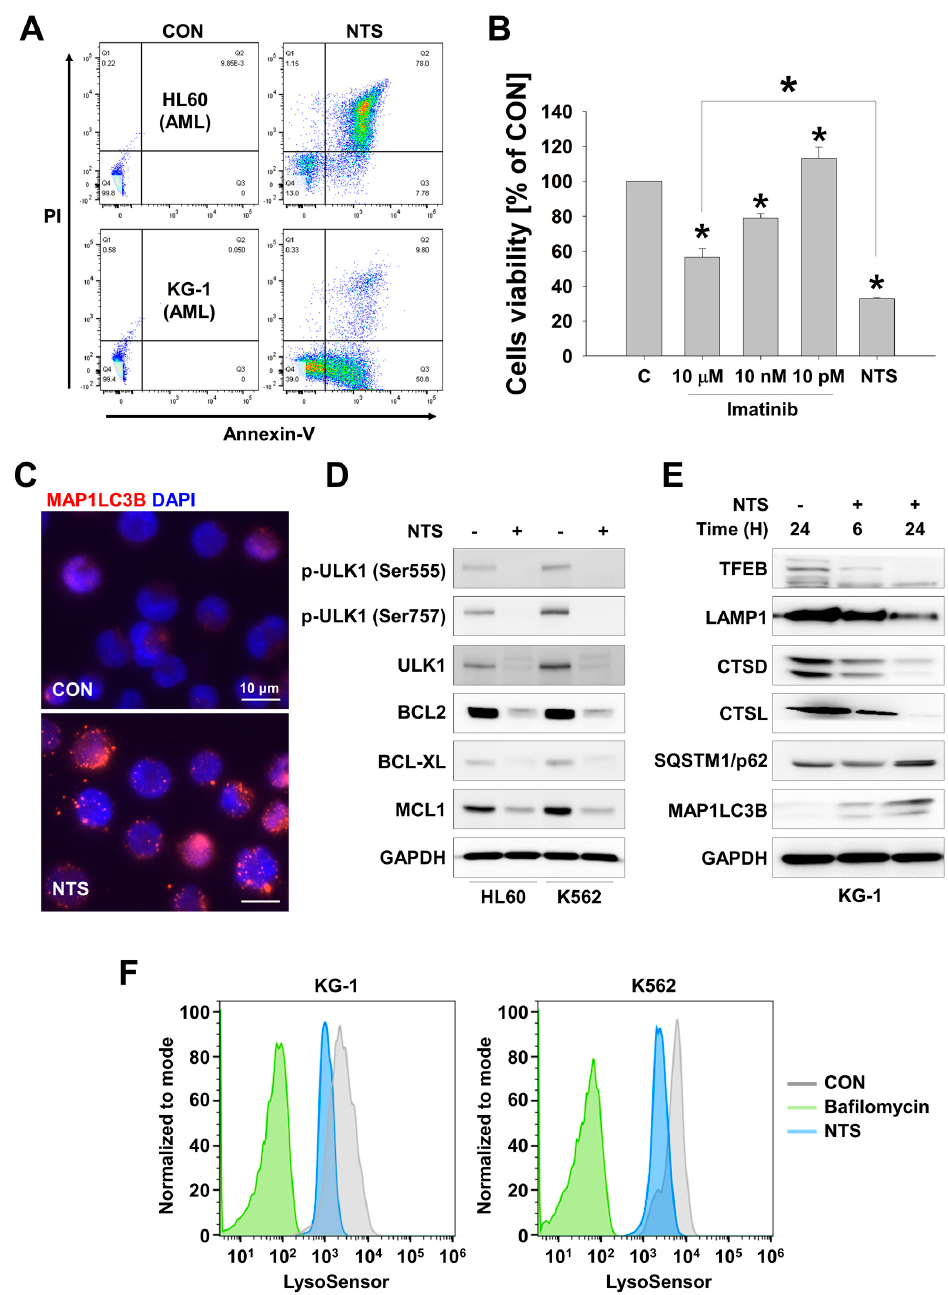
Figure 1. Non-thermal plasma-treated solution (NTS) induces leukemia cell death through lysosomal inhibition. ( A ) FACS analysis of NTS-induced leukemic cell death in HL60 and KG-1 AML cell lines. Cell death was determined by Annexin V/PI staining. ( B ) Antileukemic effects of NTS versus Imatinib in HL60 cells. Cell viability was determined by 3-(4,5-Dimethylthiazol-2-yl)-5-(3-carboxymethoxyphenyl)-2-(4-sulfophenyl)-2H-tetrazolium (MTS) assay. Data are presented as mean ± SD. n = 6, * P < 0.05. ( C ) NTS-induced MAP1LC3B accumulation in leukemia cells. NTS-induced autophagy, indicated by MAP1LCB puncta, was visualized using immunocytochemistry. Scale bar-10 µ m. ( D ) Western blot analysis of autophagy- or mitochondrial function-related signaling pathways affected by NTS. ( E ) Western blot analysis of lysosomal protein expression in KG-1 cells treated with NTS for 6 or 24 hours. ( F ) FACS analysis of lysosomal activity in KG-1 (AML) and K562 (CML) cells treated with NTS. Bafilomycin (100 nM, 24 hours) was used as a positive control. CON: